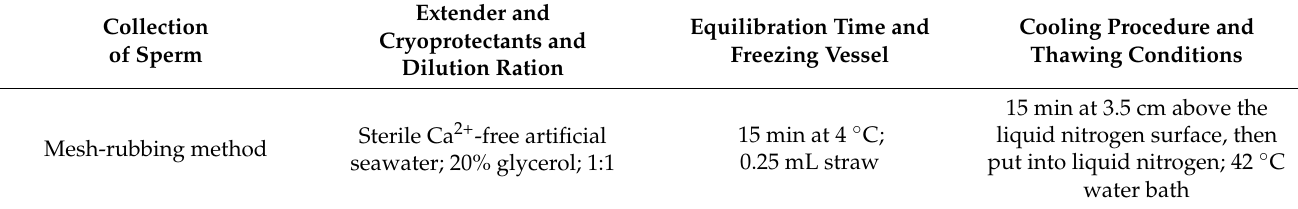
Table 1. Optimal sperm cryopreservation formulation of P. trituberculatus